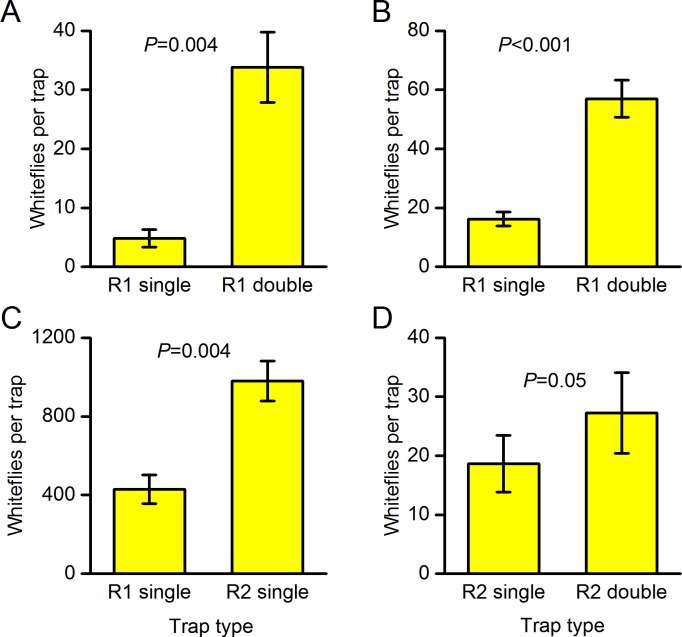
Effects of trap translucency on the number of whiteflies caught on sections of yellow sticky roller trap.Mean catch on both sides of the trap ± SE. (A) Experiment A in 2016 comparing single and double thicknesses of roller trap type R1 (moderate translucency) (n = 6), (B) experiment A repeated in 2017 (n = 9), (C) experiment B comparing single thicknesses of roller trap type R1 (moderate translucency) with roller trap type R2 (less translucency) (n = 9), (D) experiment C comparing single and double thicknesses of roller trap type R2 (less translucency) (n = 8). Differences in trap catch between experiments reflect trap area, crop infestation and the duration of each experiment, so comparisons of treatments between experiments are not valid.